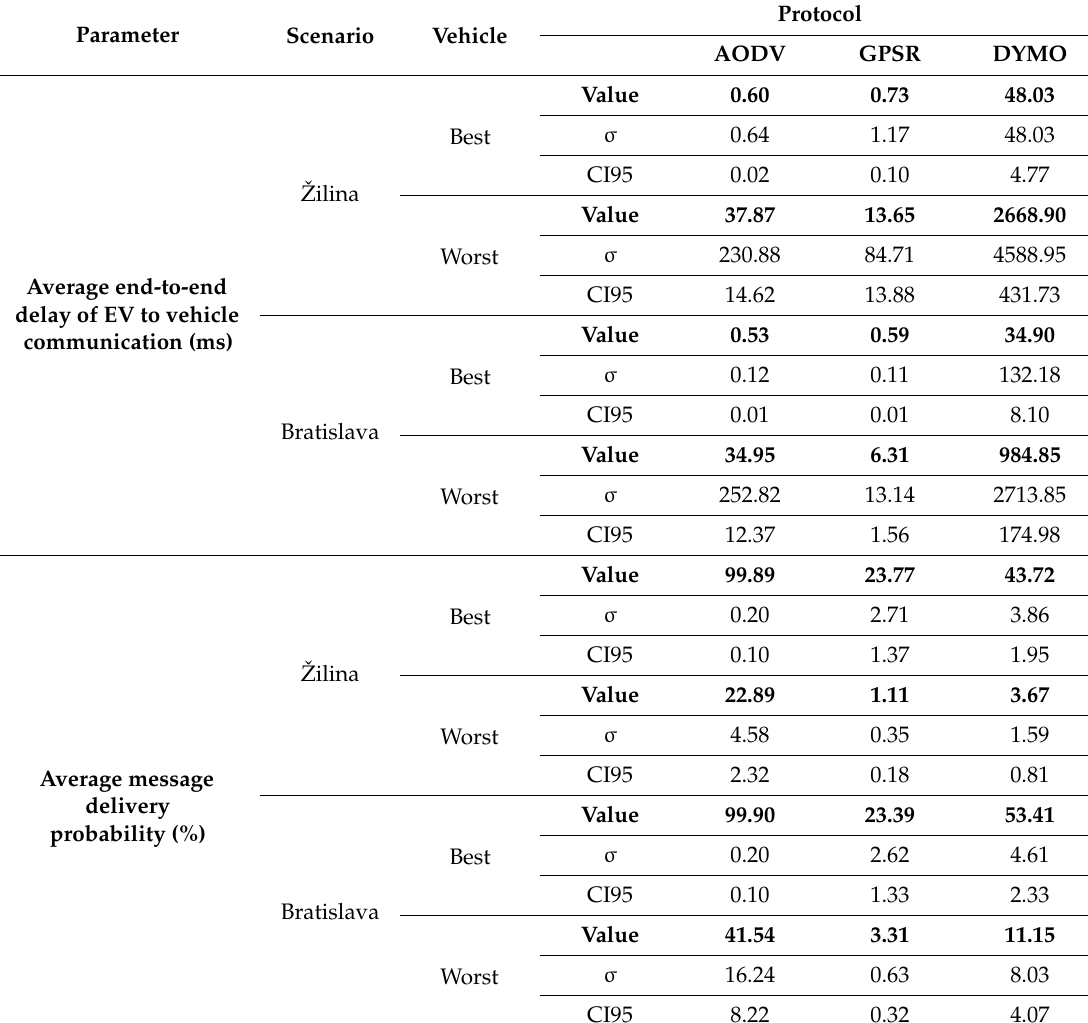
Table 3. Comparison of routing protocols. We report the average values for the end-to-end delay of the EV to vehicle communication and the message delivery probability calculated over 15 independent simulation runs and over messages delivered to the best-case and the worst-case vehicles (row Value). The corresponding standard deviation (row σ ) and the size of the 95% confidence interval (row CI95) are reported as